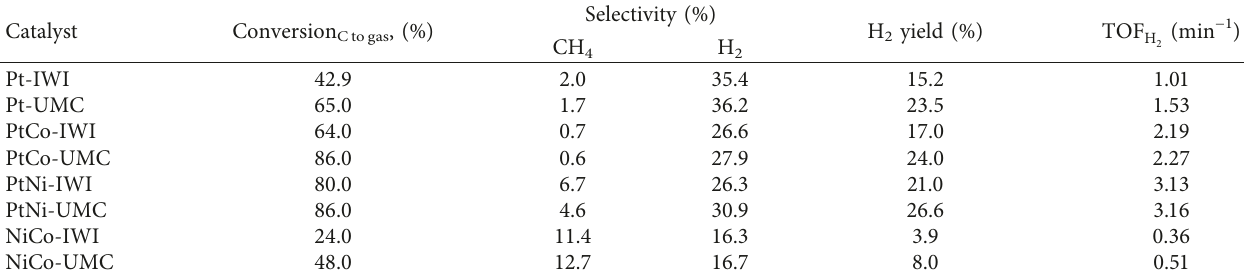
Table 2: Results of APR of aqueous ethylene glycol (10% w).